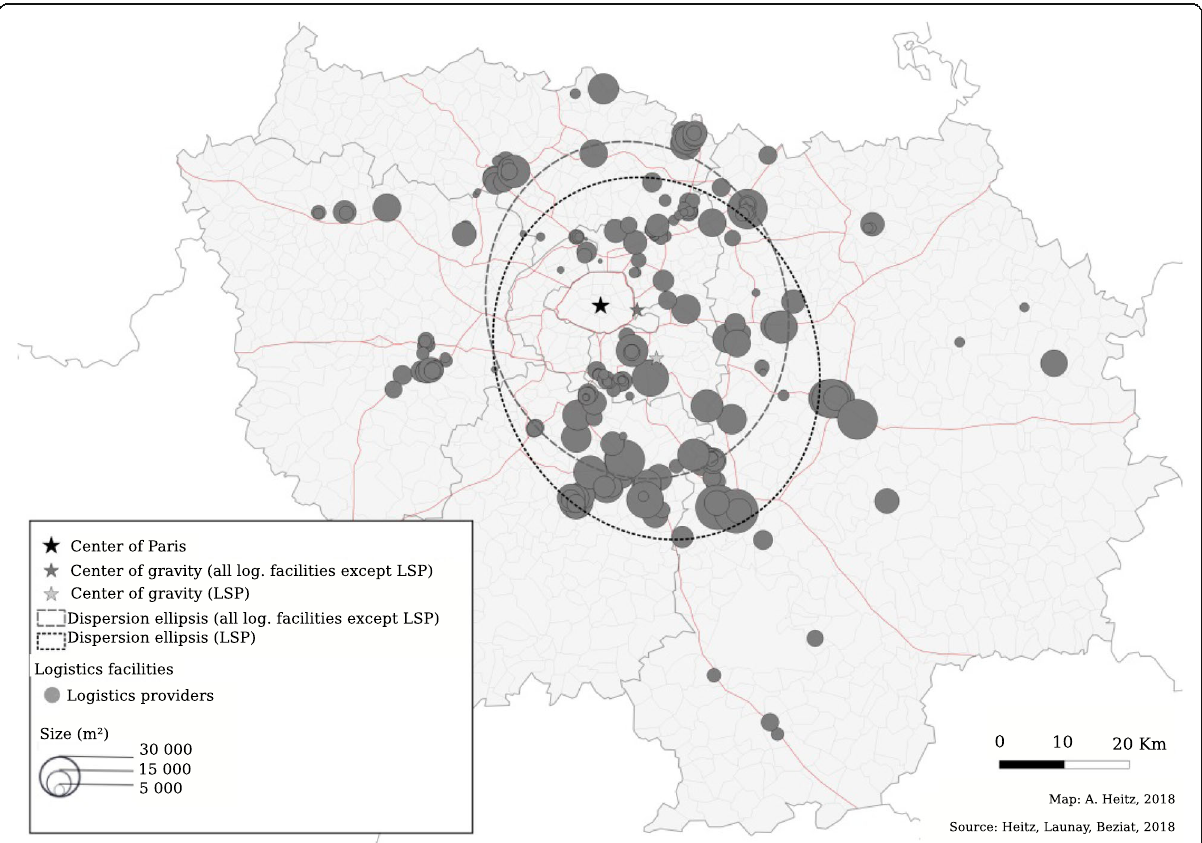
Fig. 5 Location of LSP facilities in the Paris